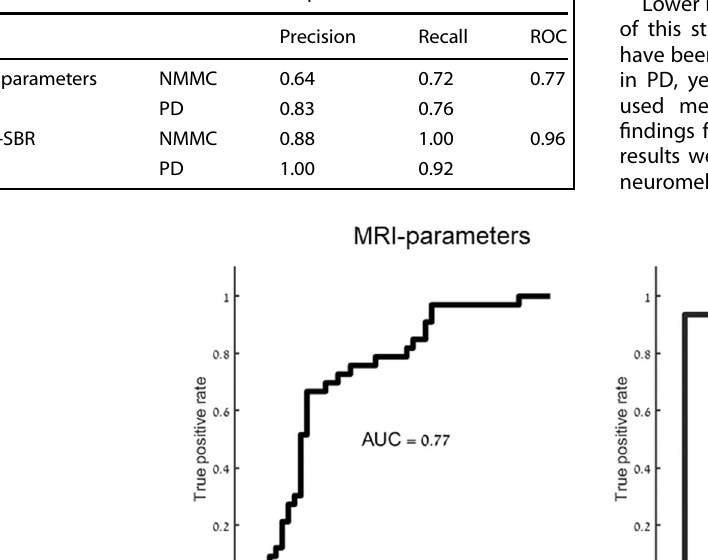
Table 3. Classi fi cation results between patients with PD and NMNC.